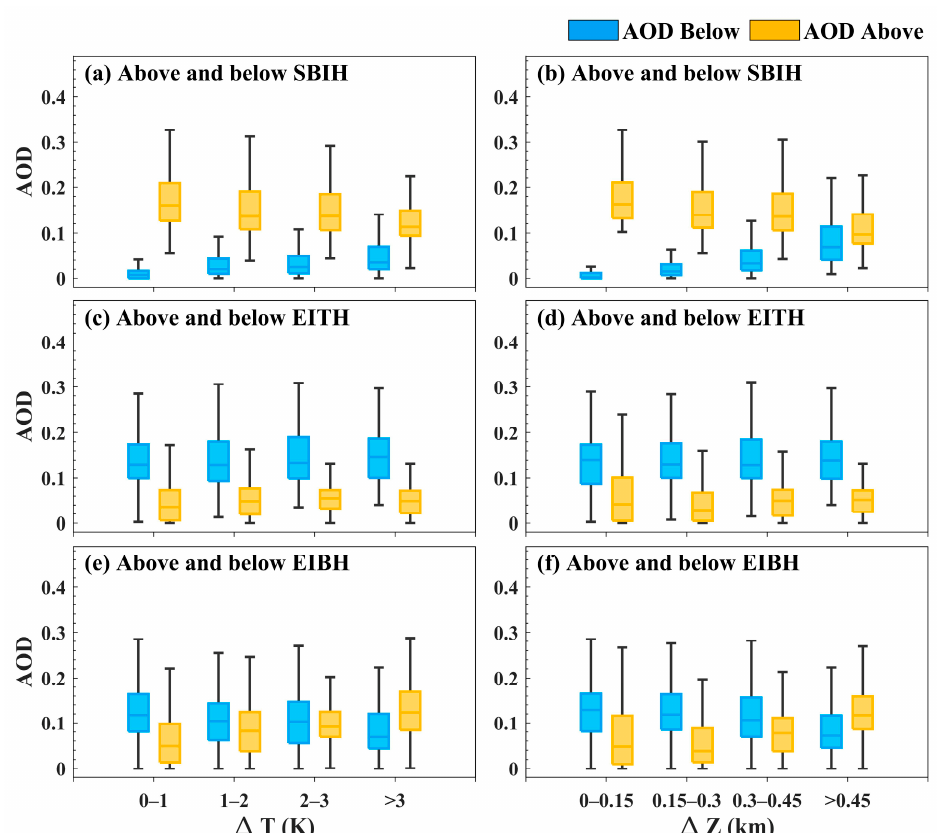
Figure 8. The Aerosol optical depth above and below ( a ) surface-based inversion height, ( c ) elevated temperature inversion top height, and ( e ) elevated temperature inversion bottom height under different inversion intensity conditions. The Aerosol optical depth above and below ( b ) surface-based inversion height, ( d ) elevated temperature inversion top height, and ( f ) elevated temperature inversion bottom height under different inversion depth conditions. The blue and orange boxes represent the aerosol optical depth below and above temperature inversion, respectively.